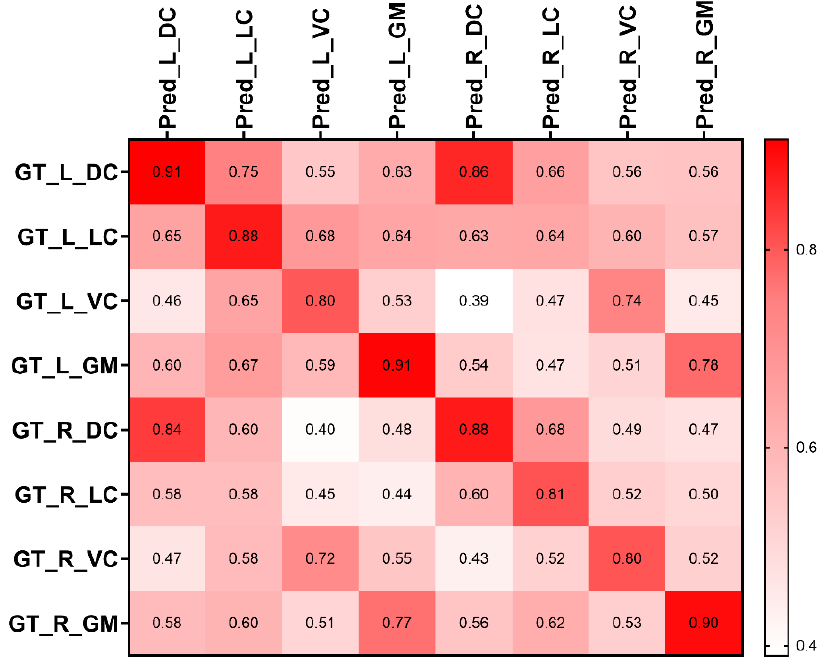
Figure 8. The correlation between FA of predicted segmentation ROIs and FA of ground truth ROIs. Pred_: the ROIs from the proposed segmentation model; GT_: the ROIs from the manual segmentation. Table 3. The percentage of absolute error between two types of FA value.